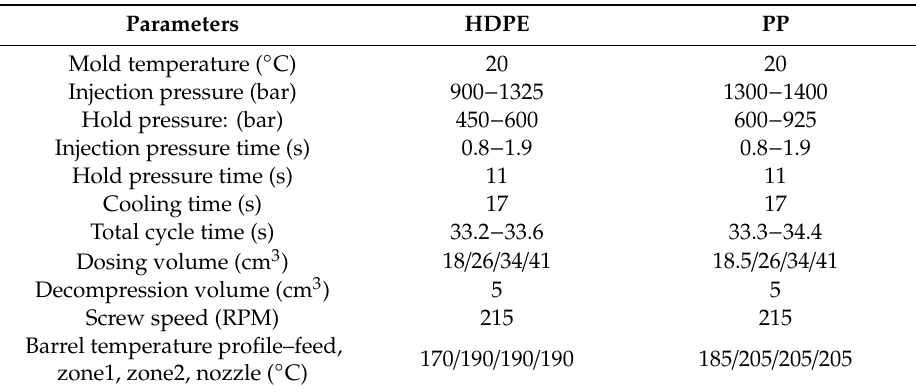
Table 1. Injection molding machine